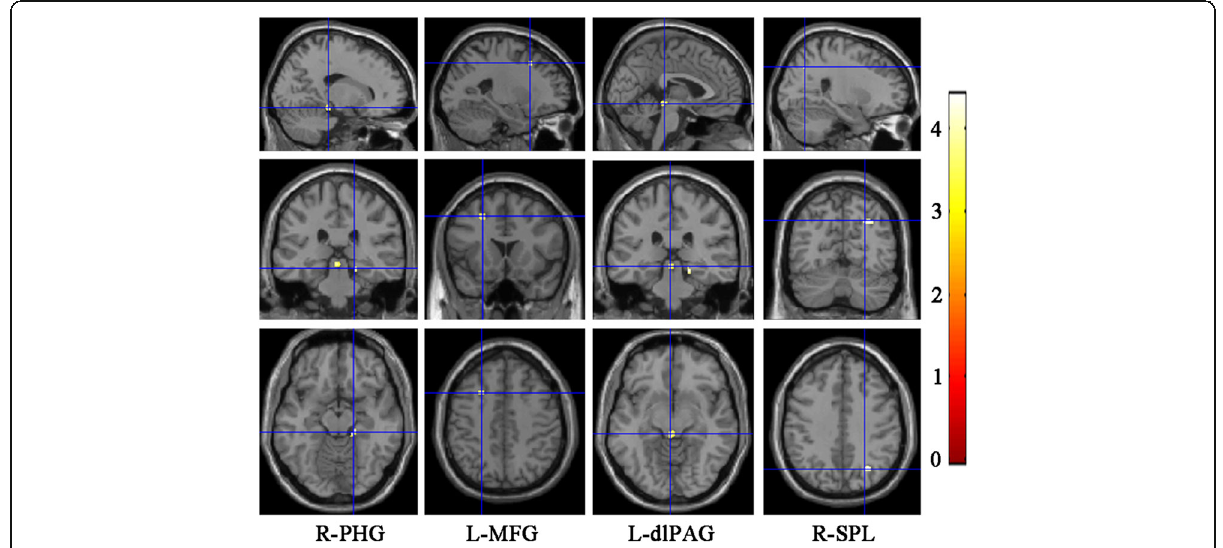
Fig. 4 The increased (1 – 3 column) and decreased Correlation in MOH compared with normal controls. R, right hemisphere; L, left hemisphere; PHG, parahippocampal gyrus; MFG, middle frontal gyrus; dlPAG, dorsolateral periaqueductal gray; SPL, superior parietal